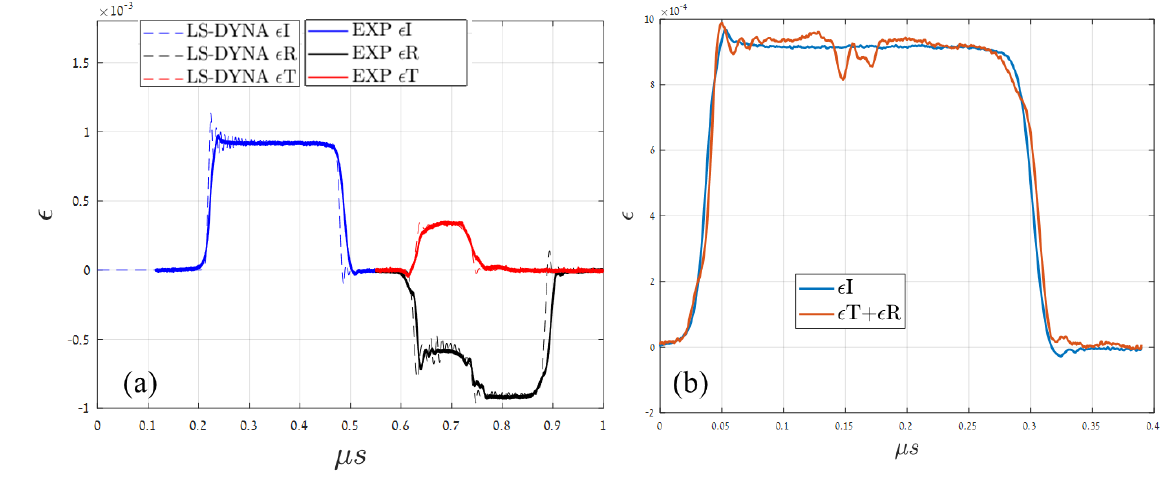
Figure 2. (a)- Comparison between the simulated strains (dashed) and the measured strains (solid), (b)- force equilibrium validation 𝜀 𝑇 + 𝜀 𝑅 in orange and 𝜀 𝐼 in blue